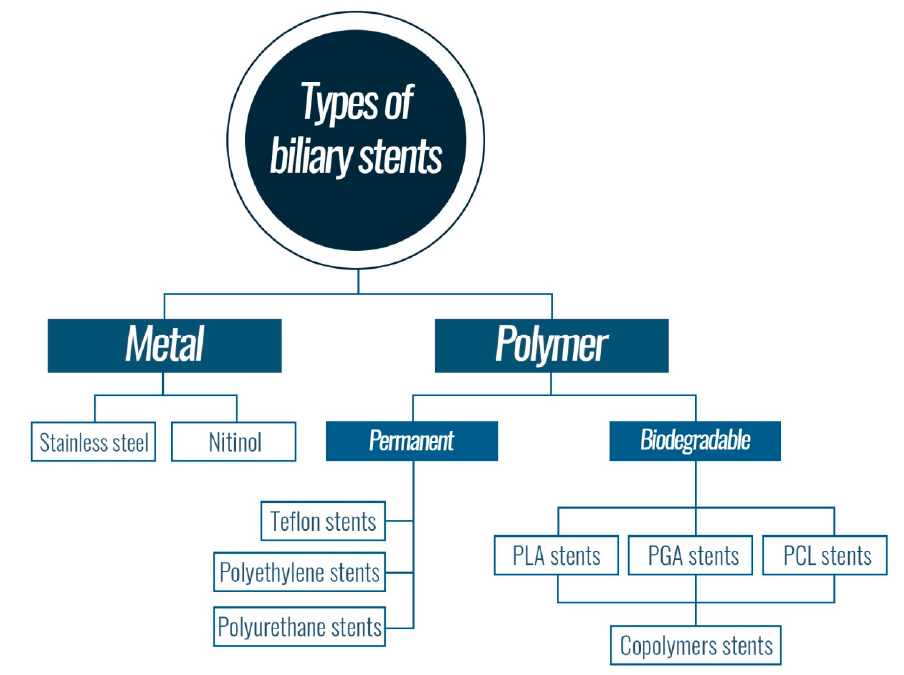
Figure 6. Types of biliary stents.